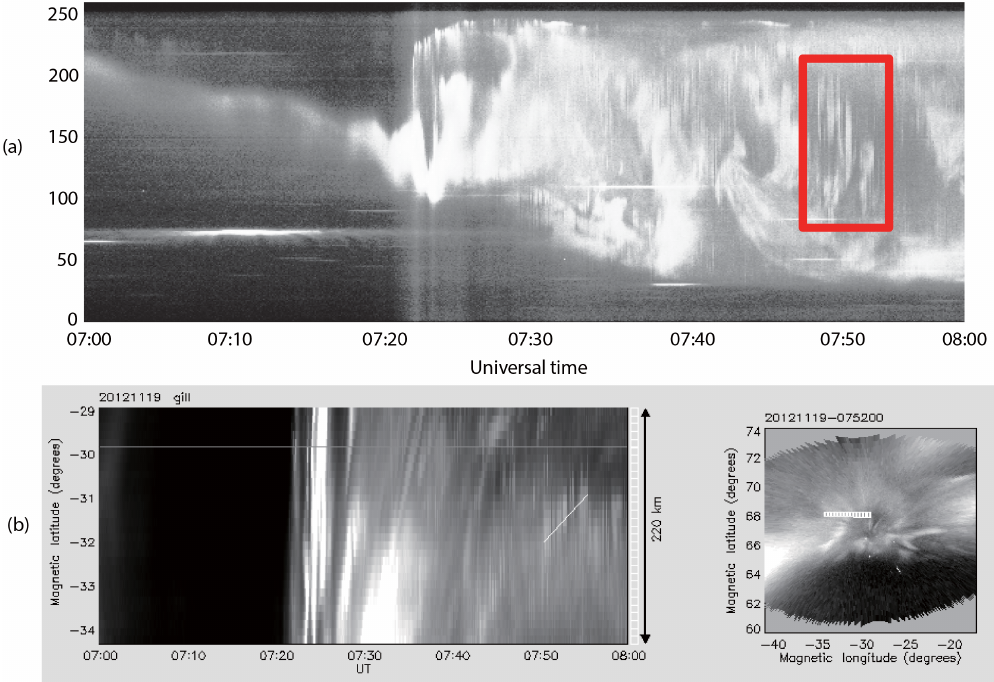
Figure 2. (a) A 1h keogram from 07:00 to 08:00UT on 19 November 2012. The horizontal axis is universal time and the vertical axis is the number of pixels. The red frame indicates where the PPA patch is identified. (b) A 1h ewogram from 07:00 to 08:00UT on 19 Novem- ber 2012. The horizontal axis in the left panel is the universal time and the vertical axis in the left panel is the magnetic longitude. The right panel is an all-sky image in geomagnetic coordinate. The white line in the left panel indicates the motion of the identified PPA patch and that the white rectangle in the right panel indicates the pixels used to construct the